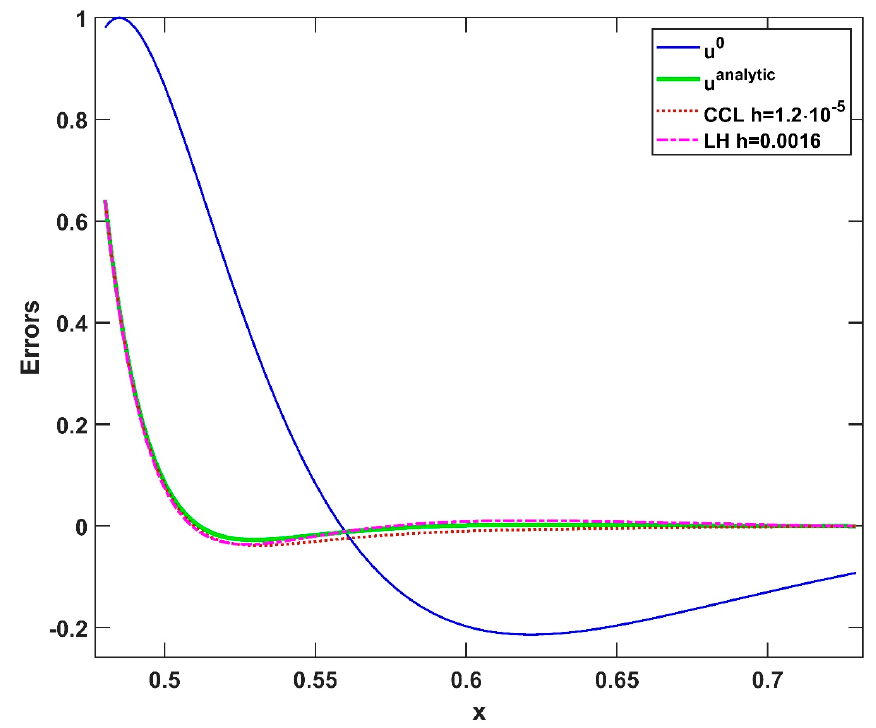
Figure 9. The variable u as a function of x in the case of the initial function u 0 , the analytical solution at the final time, the CCL algorithm for h = 1.2 × 10 − 5 , and the LH algorithm for h = 0.0016 in the case of large value of m (Experiment 2).